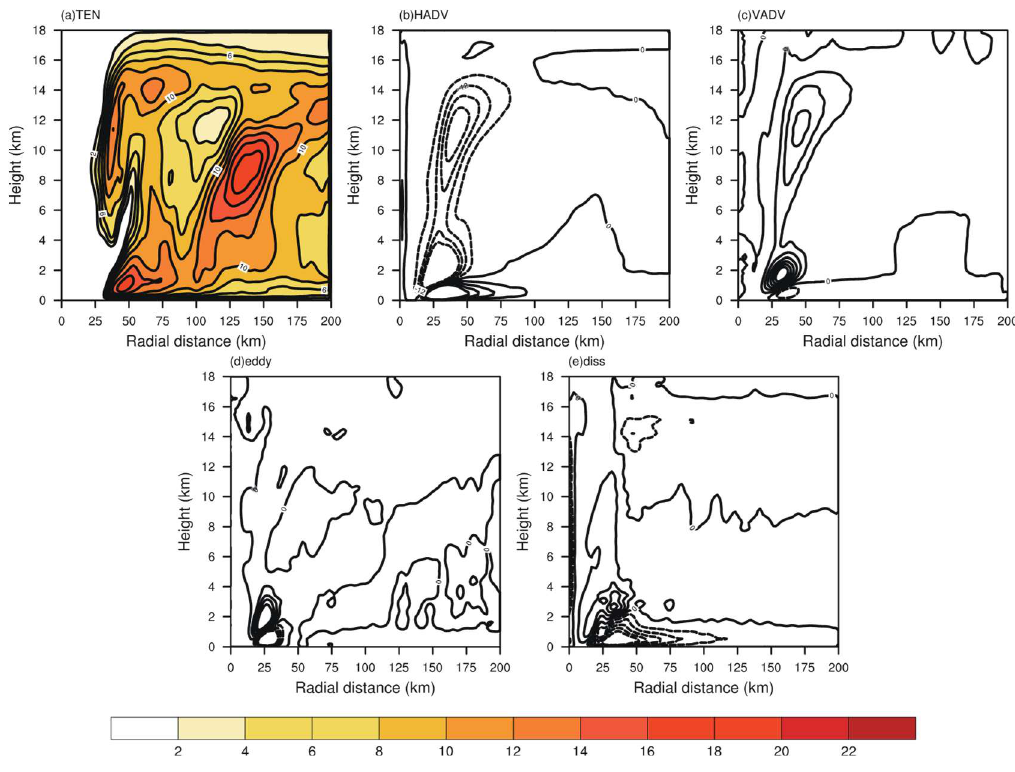
Figure 12. As in Figure 3, but for HY.